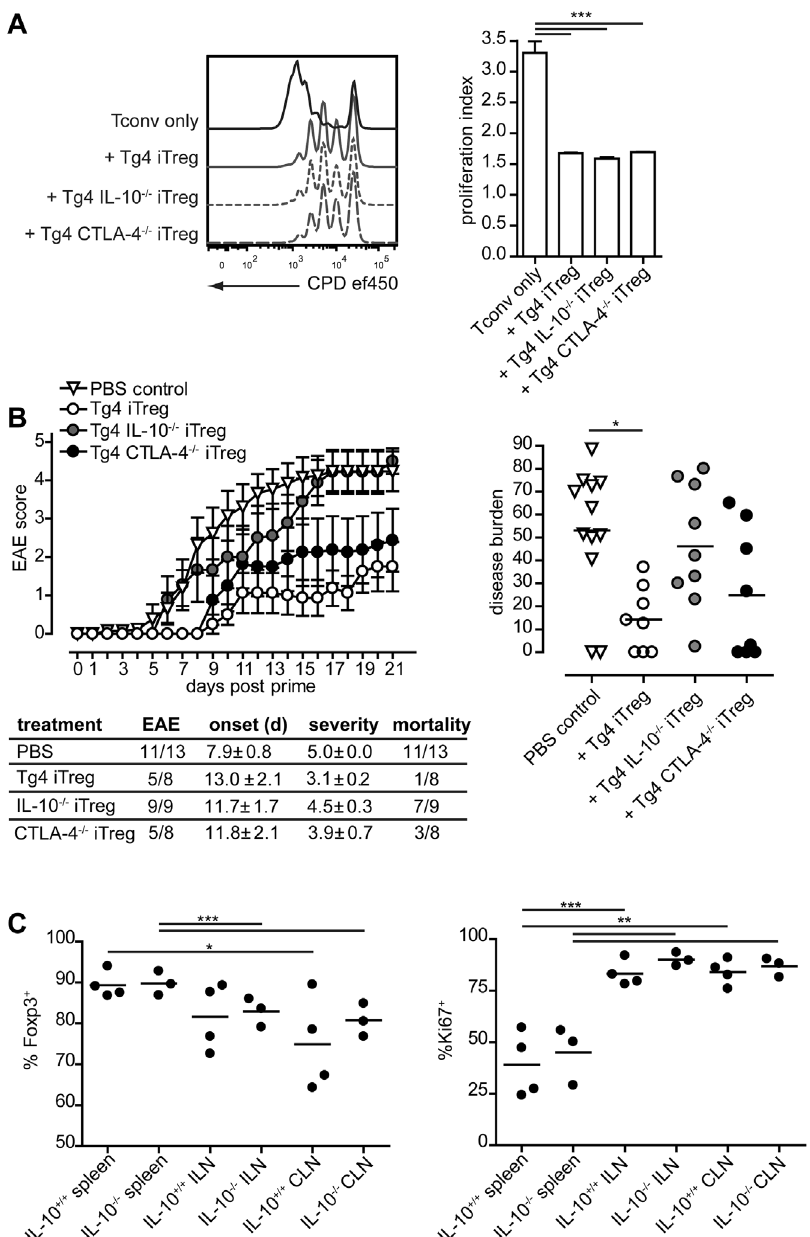
Figure 4. iTreg cell function is mediated by IL-10 and CTLA-4 . A. CPD-ef450-labeled naive CD4 + Tg4 CD45.1 + T cells cultured in vitro for 4 days with or without Tg4 CD45.2 + iTreg cells and stimulated with 1 m g/ml MBP Ac1–9 and irradiated APCs. Representative overlays gated on CD45.1 + cells (left) and proliferation index as means of triplicates + SEM (right). Representative of 3 or more similar experiments. *** P , 0.001, one-way ANOVA with Dunnett’s post-test. B. Tg4 Rag 2 / 2 mice received 5 6 10 6 iTreg cells in PBS or PBS only, i.p., 3 days prior to EAE induction. Data in each line were combined from 2 or more individual experiments and are shown as mean 6 SEM. Distribution plot shows disease burden for each individual in each group * P , 0.05, Kruskal Wallis with Dunn’s post-test comparing all pairs of columns. No statistically significant differences exist between other column pairs. C. Tg4 CD45.1 + mice received 5 6 10 6 Tg4 CD45.2 + iTreg cells, i.p., 72 hrs prior to priming with MBP Ac1–9 in CFA. On day 7 post-prime, spleens, inguinal lymph nodes (ILN) and cervical lymph nodes (CLN) were removed and isolated cells analyzed for Foxp3 (left) and Ki67 (right) expression by FACS. Accumulated results from 4 Tg4 IL-10 + / + and 3 Tg4 IL-10 2 / 2 mice, gated on CD45.2 + cells. ** P , 0.01, *** P , 0.001, Tukey’s multiple comparison test. doi:10.1371/journal.pone.0108023.g004 SEM of 76.6% 6 1.5 for wild-type Tg4, 77.4% 6 1.6 for Tg4 IL- 10 2 / 2 and 27.6% 6 6.7 for Tg4 CTLA-4 2 / 2 ) and remained, albeit less pronounced, until day 7 (95.0% 6 0.9 wild-type,